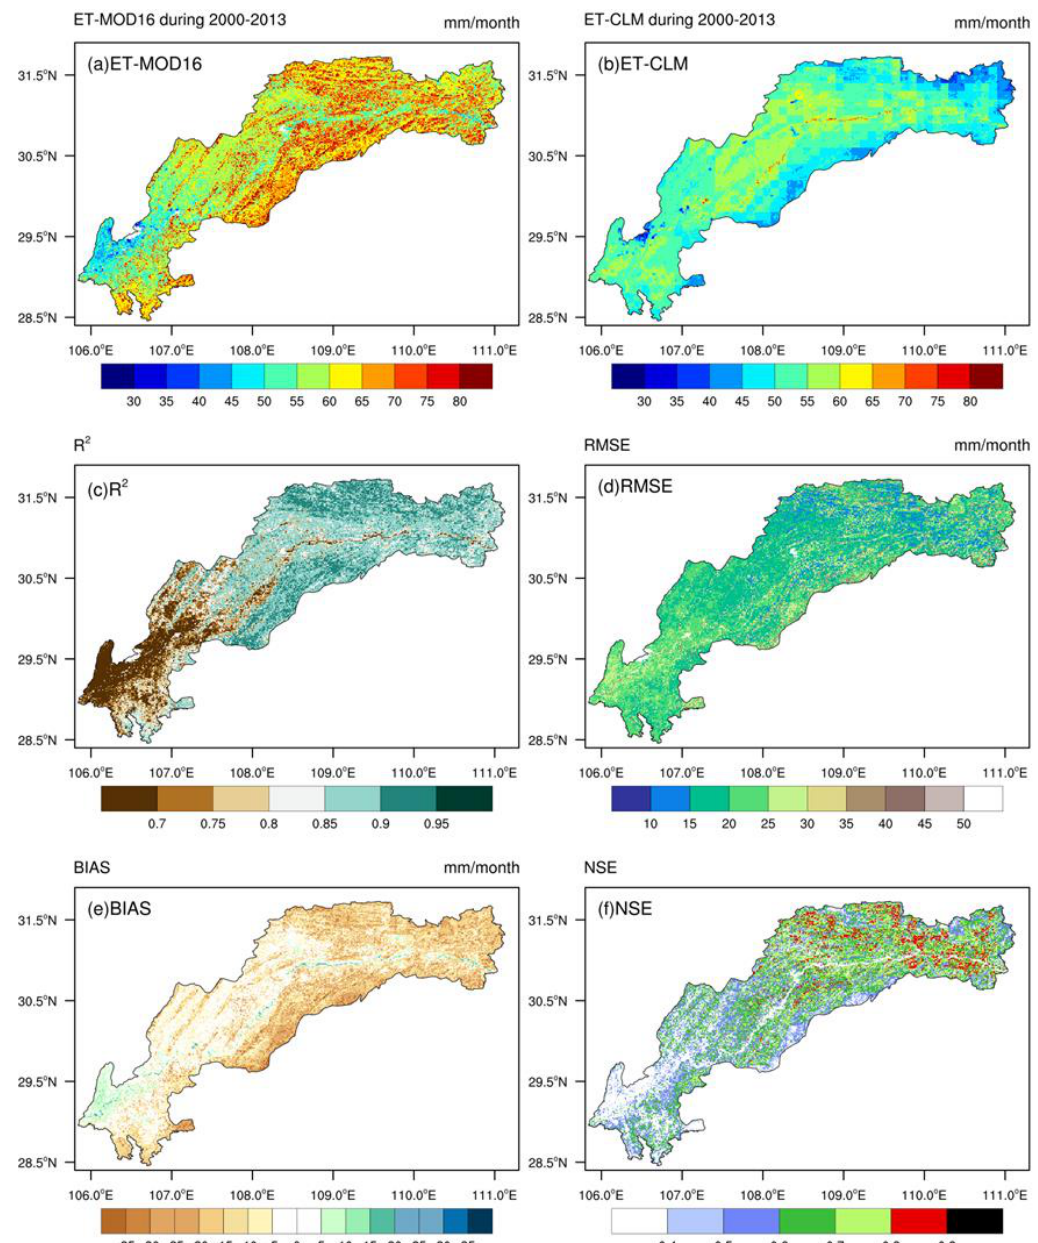
Figure 7. The spatial distribution of ET-MOD16 and ET-CLM and their evaluation indicators.